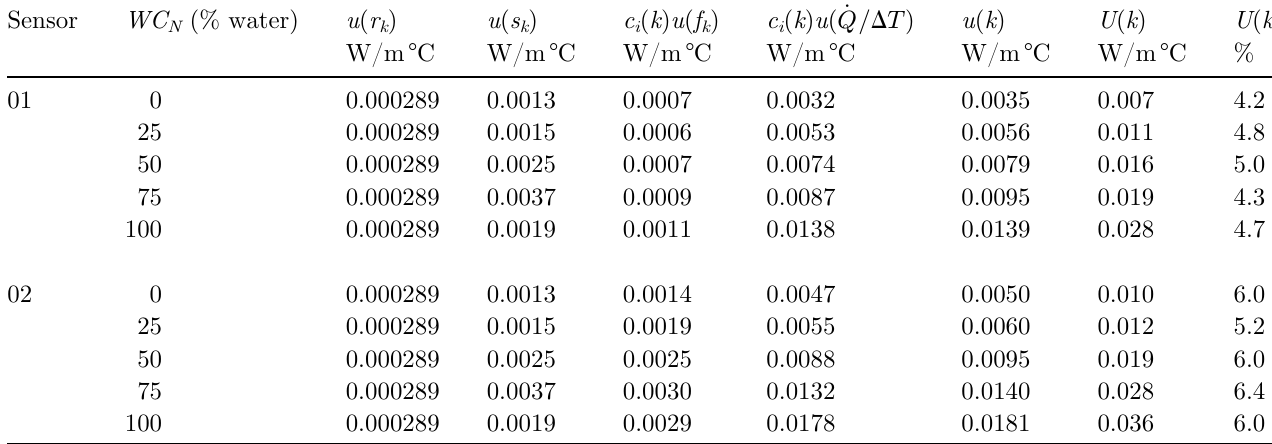
Table 7. Uncertainties for the thermal conductivities of the samples. Sensor